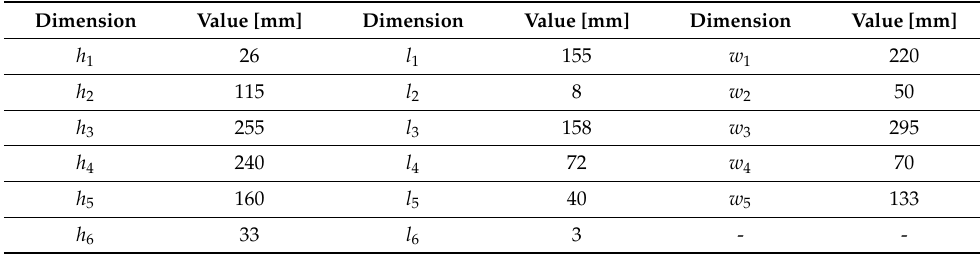
Table 4. The dimensions of the movable belt holder and heating unit assumed for calculations (Figures